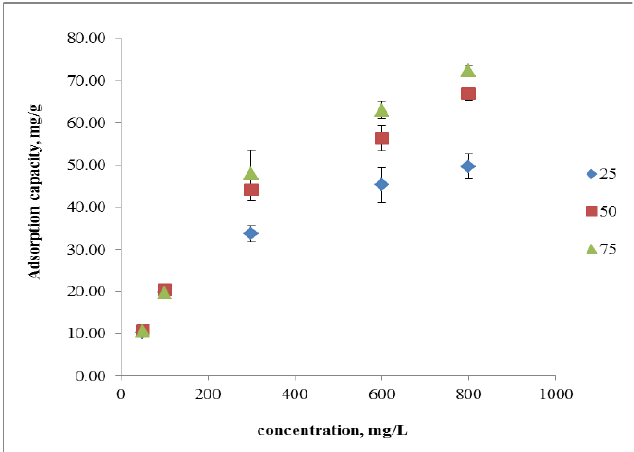
Figure 3. Effect of different initial concentrations at different temperatures on the adsorption capacity of peh-g-opefb for copper